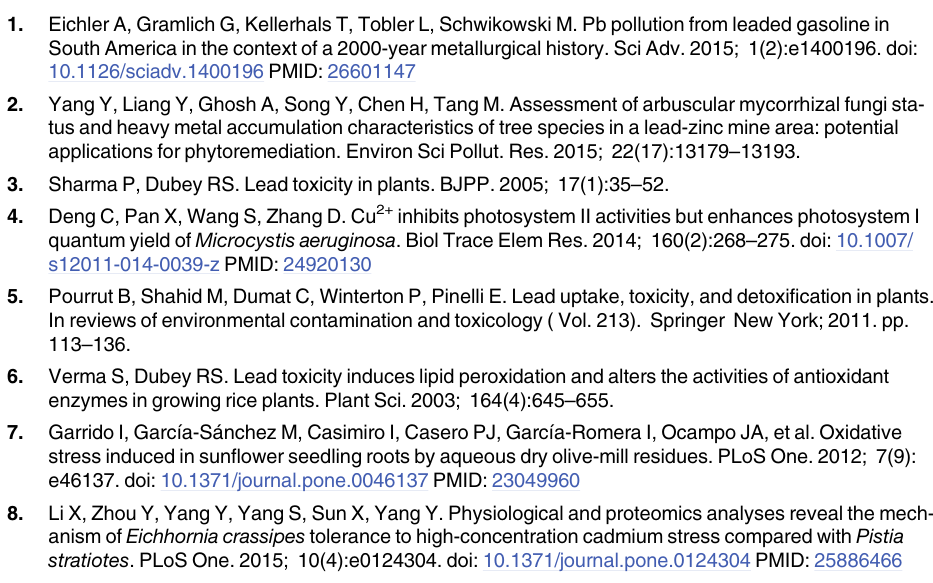
, C , T and WUE in R . pseudoacacia s i r O and MDA contents in R . pseudoacacia 2 2